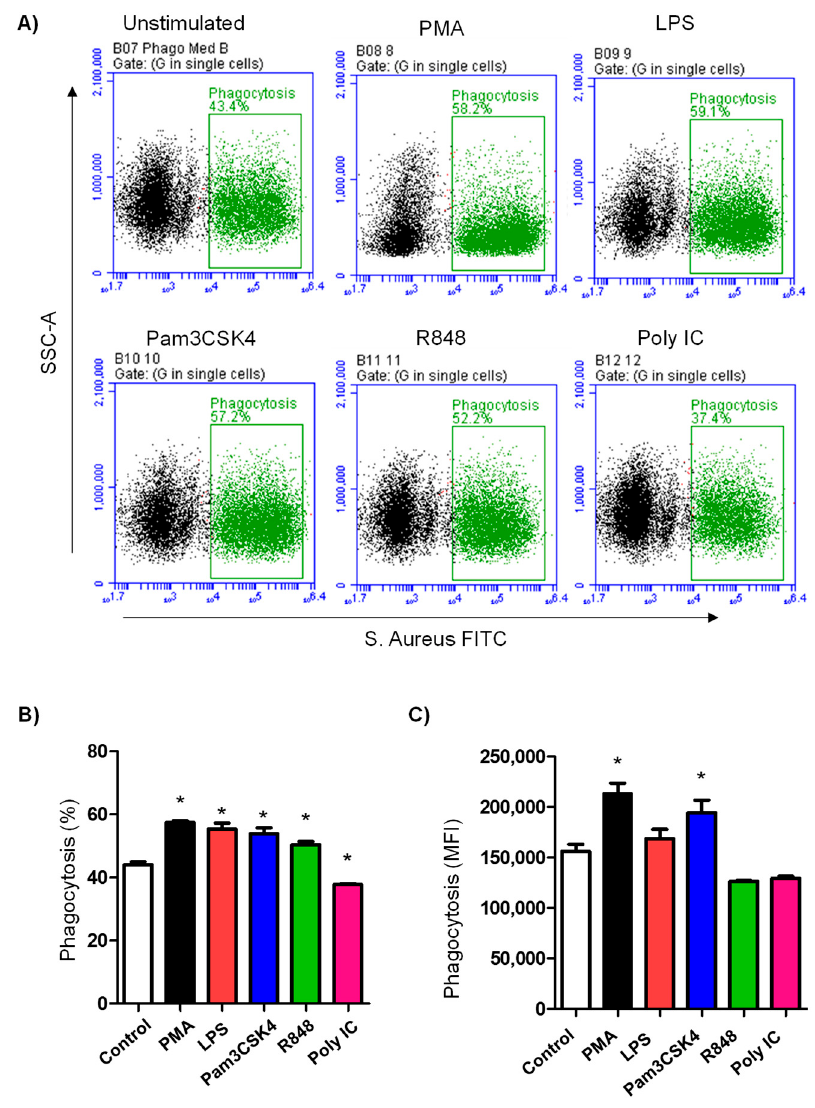
Figure 2. Analysis of neutrophils phagocytosis activity by flow cytometry. ( A ) Non-stimulated and stimulated camel neutrophils were incubated with FITC- S. aureus and analyzed on the flow cytometer. Phagocytic neutrophils were identified as cells with higher fluorescence in the FL-1. The fraction of phagocytic cells ( B ) as well as their staining intensity (MFI) ( C ) were presented for stimulated and non-stimulated neutrophils. * indicates a p value < 0.05.